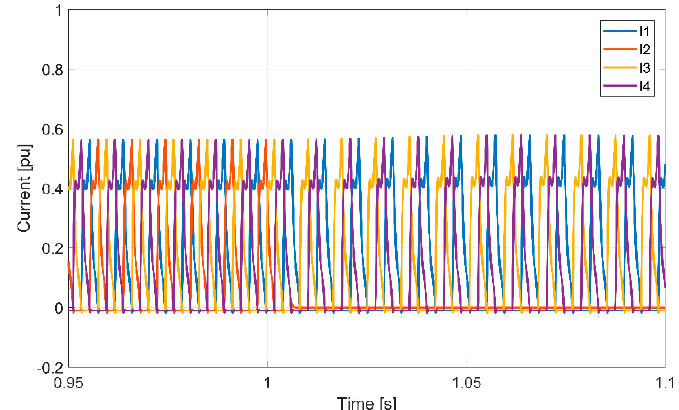
Figure 12. Motor winding currents of the SRM at 2850 rpm in normal condition and open-circuit failure of power device S 1 C (simulation result).